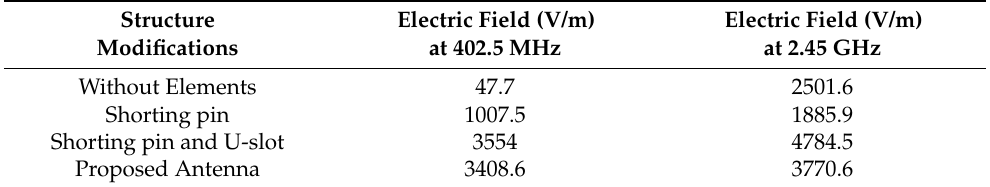
Table 3. Maximum Electric Field and Antenna Structure Modifications extracted from the